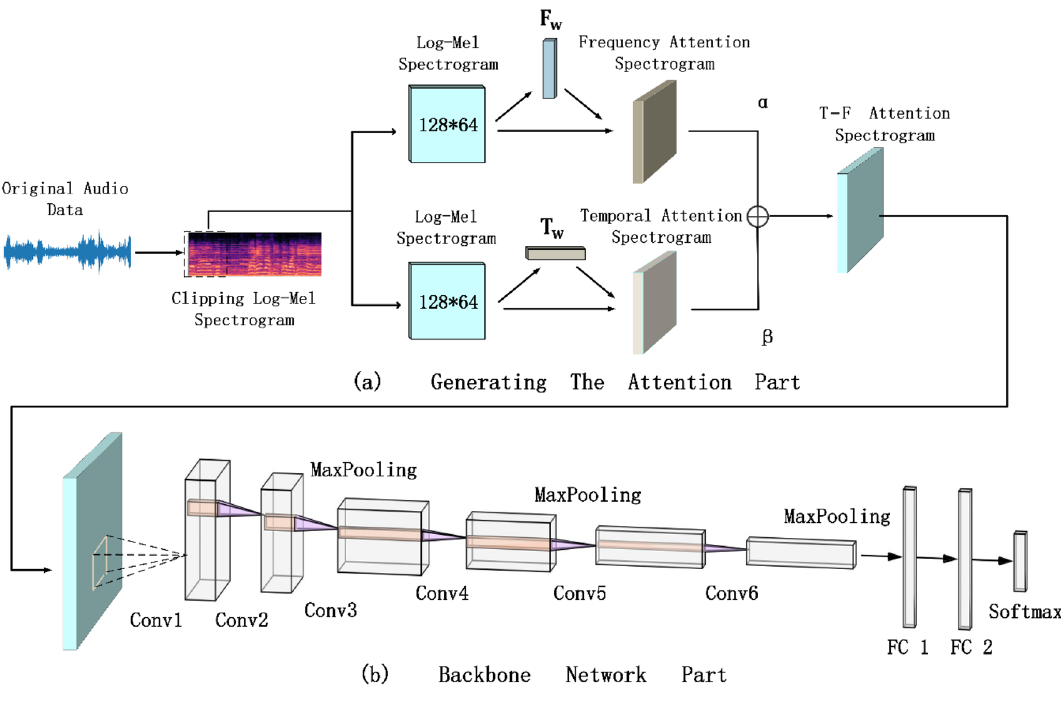
Figure 3. The overall architecture of the proposed TFCNN classification model.